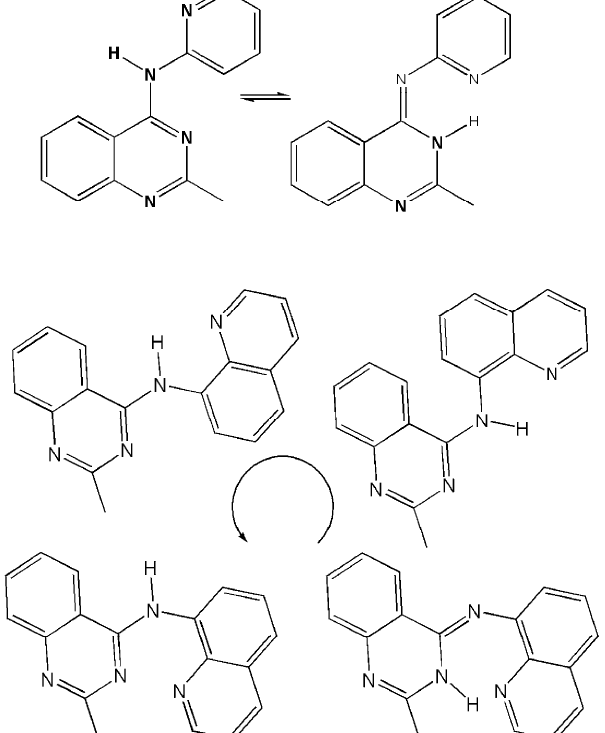
Figure 3. Complexes of model two-layered quadruplex Q2 with hetero-ligands, left: Q2 + 4 ; center: Q2 + 9 , N3H tautomer; right: Q2 + 1 . In addition, see Figure S1 for opposite conformation of 1